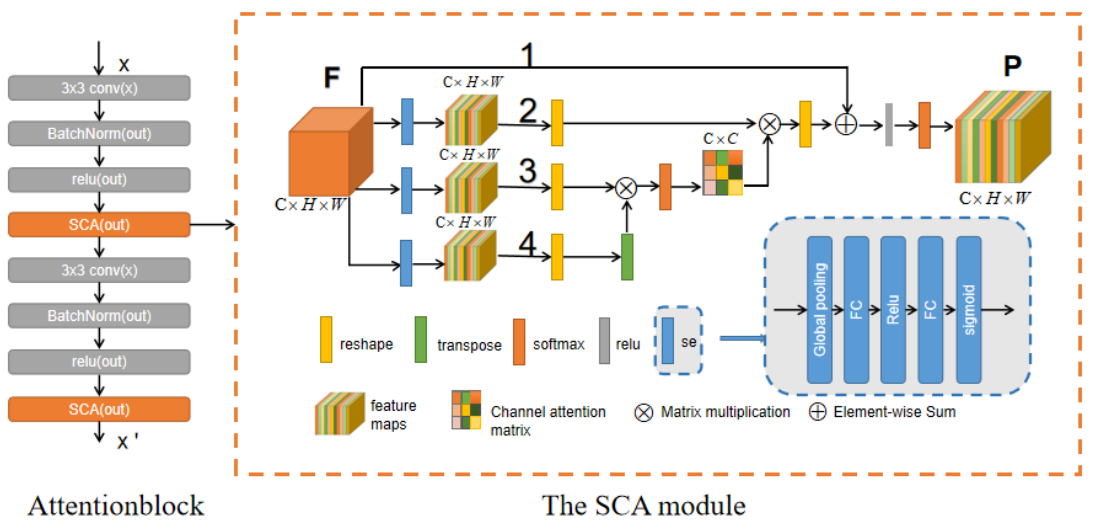
Figure 3. Left is the overall structure of the Attentionblock, right is the structure of the channel attention module